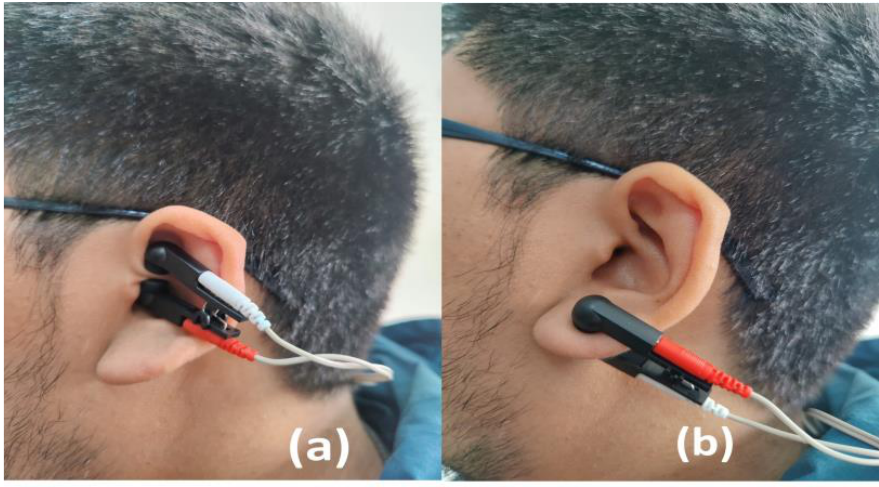
Figure 2. Active ( a ) and Sham ( b ) conditions of TVS.